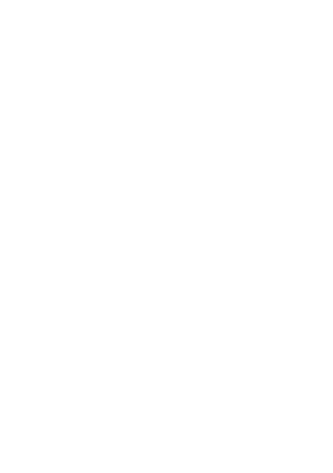
Figure 14. Distribution of the stress variation angle after the tunnel excavation in the basic case of AR2C3.